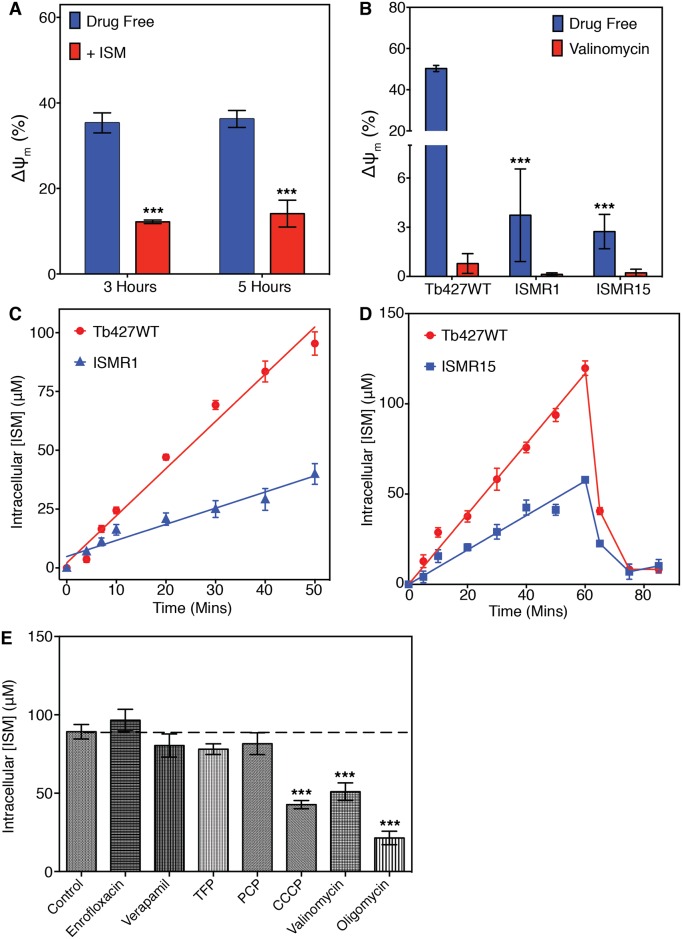
Adaptation giving resistance to ISM reduces the mitochondrial membrane potential and ISM uptake capacity.(A) Mean mitochondrial membrane potential (ΔΨm) with SEM of Tb427WT trypanosomes incubated with or without 0.5 μM ISM for 3 or 5 hours. ΔΨm is recorded in arbitrary units (A.U.) of fluorescence, and flow cytometer is calibrated at the start of the experiment to have exactly 50% of cells with a value of 100 A.U. and over for the drug-free cells (control at t = 0 h). ***, P-value <0.001 (Student’s t-test, n≥3) of the ISM-treated cells relative to their untreated controls. (B) Mean ΔΨm with SEM of ISM resistant cell lines compared to the parental Tb427WT. Valinomycin was used as a positive control. ***, P-value <0.001 (Student’s t-test, n≥3) relative to WT control. (C) Graph showing the means (and SEM) of 3 independent experiments measuring uptake of ISM by the parental Tb427WT and ISMR1 cell lines. For each of the experiments single cell cultures of either Tb427WT or ISMR1 were incubated in 10 μM ISM, which were sampled in triplicate at the indicated times for the determination of intracellular ISM. (D) Graph showing the means (and SEM) of 3 independent experiments showing uptake and efflux of ISM by the Tb427WT and resistant ISMR15 strains. After incubation with 10 μM ISM for 60 minutes, the cells were centrifuged, washed and resuspended in medium without drug. The intracellular concentration of ISM was monitored in triplicate periodically before and after the removal of drug from the medium. (E) Inhibition of ISM uptake in the presence of potential inhibitors. Tb427WT trypanosomes were incubated for 20 minutes with 10 μM ISM in the absence (Control) or presence of 50 μM enrofloxacin, verapamil, TFP, PCP, CCCP, oligomycin or 1 μM valinomycin. Data presented are mean intracellular ISM concentration with SEM; ***, P-value <0.001 (Student’s t-test, n≥3) relative to untreated controls.